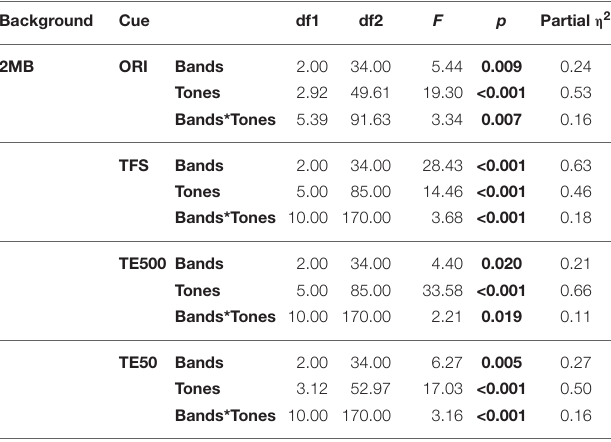
TABLE 4 | Results of Bands *Tones two-way repeated measures ANOVA on tone accuracy by Cues when Backgrounds = 2MB. Background